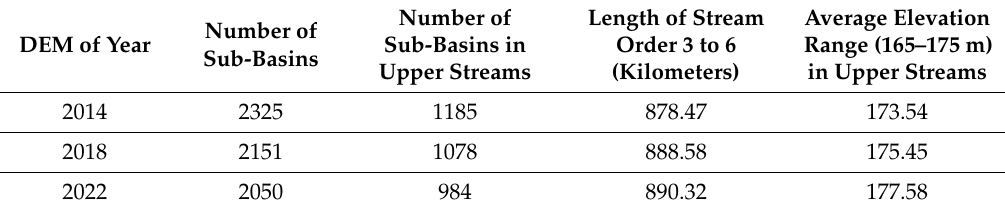
Figure 5. Maps of hydrological data ( a – f ) to use for independent variables extraction of FRS-GWR model in 2022.